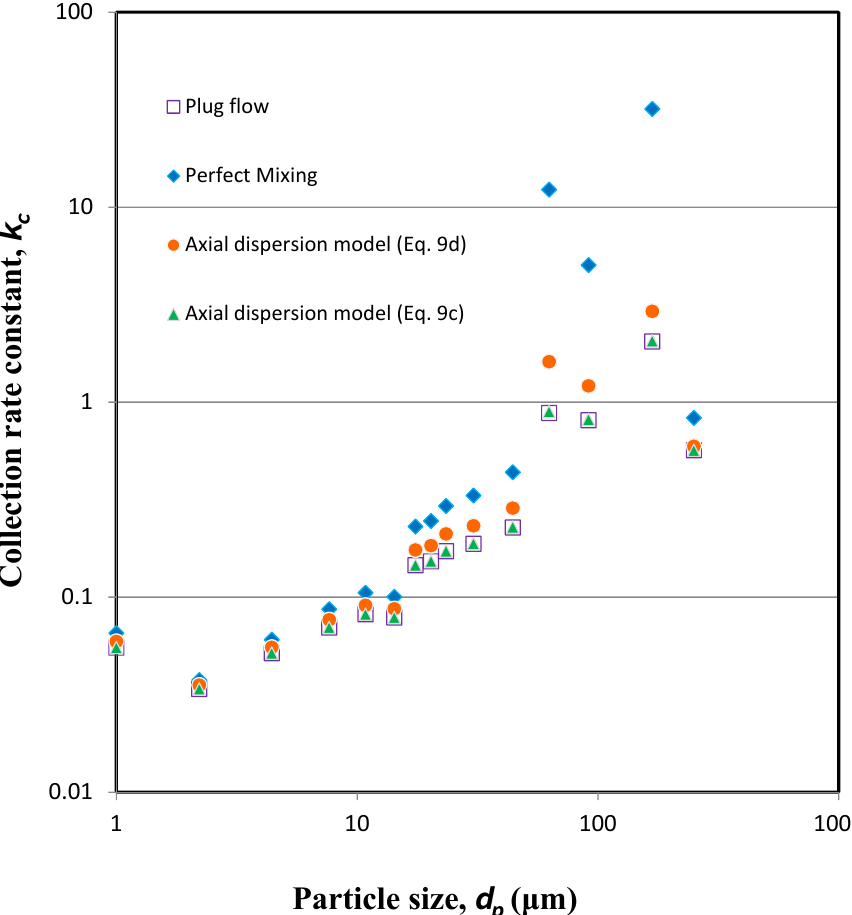
Figure 3. Comparison of calculated collection rate constant ( k c ) vs. particle size ( d p ) under various flow conditions of particles in the column.